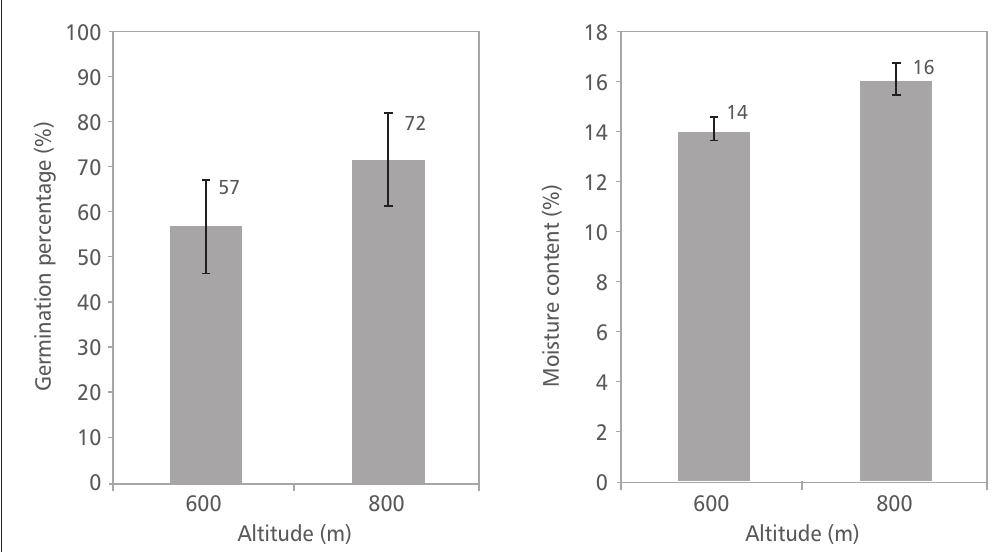
FIGURE 2. The elevations factor on seed germination and moisture content